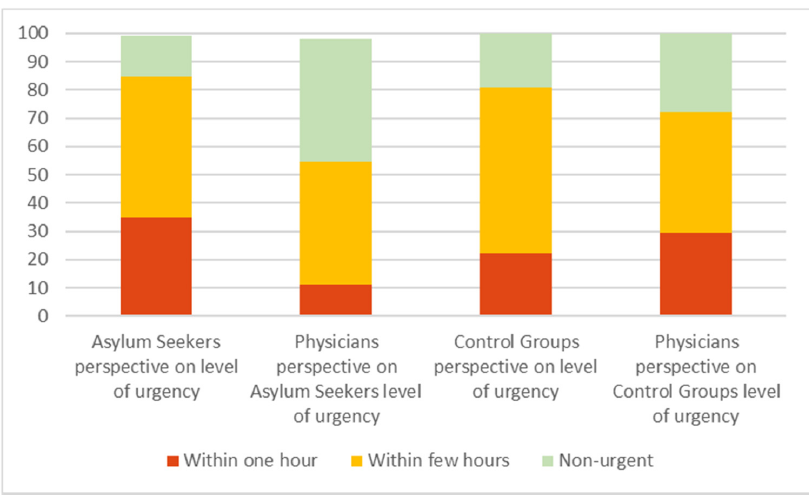
Figure 4. Assessment of the estimated level of urgency by patient vs. physician; number in % (missing answers: AS 3, CG 0).